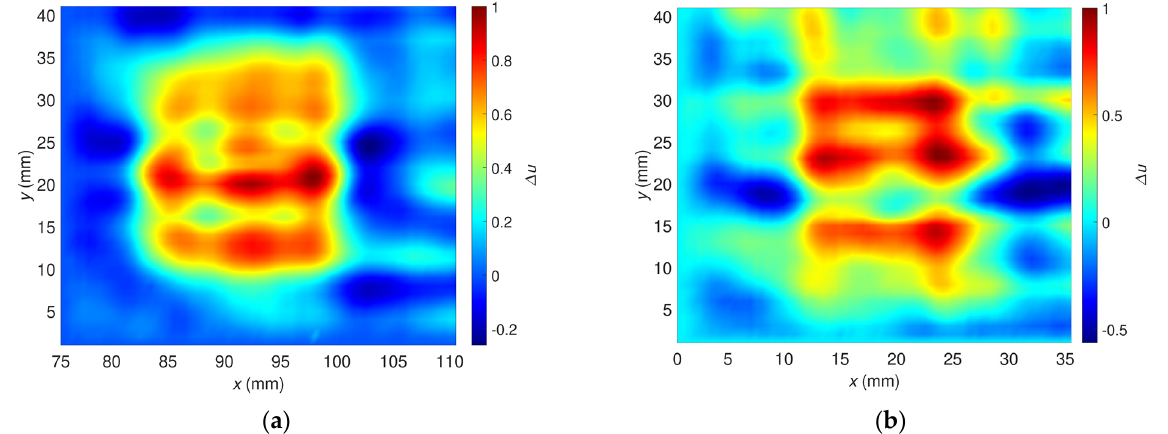
Figure 15. Two-dimensional plot of the relative voltage after background signal removal; excitation frequency f = 2 MHz; plots of the signals measured for the same side flaws (inner flaws): ( a ) IF70%, ( b )